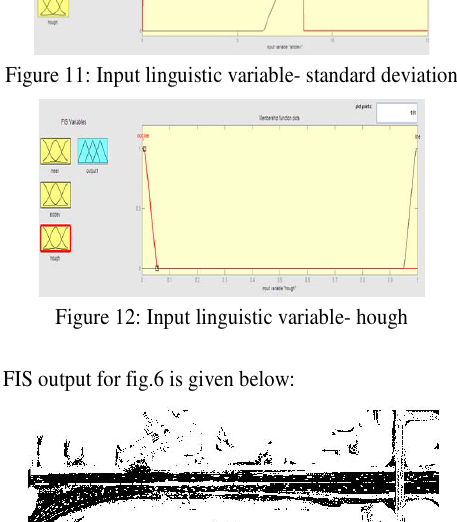
Figure 14: Finding Threshold Values